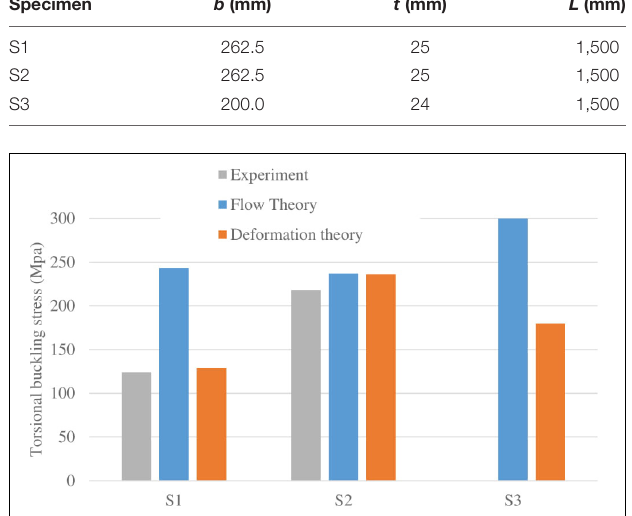
FIGURE 4 | Cross-section of cruciform column.